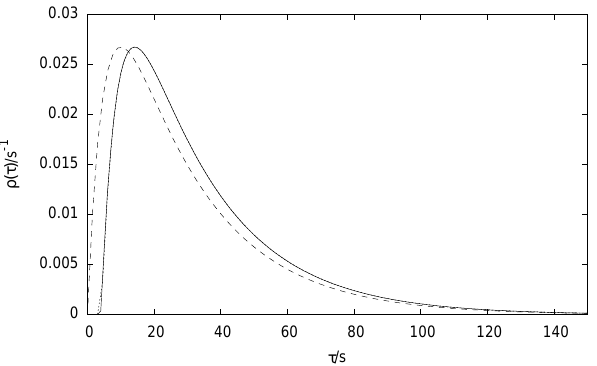
Fig. 4. Exact distribution of transcription times (solid curve replotted from figure 3), two-exponential approximate distribution (47) (dashed curve), and lag-corrected approximate distribution (48) (dotted, al- most coincident with the exact distribution). The two-exponential distribution uses the exact values of k 0 and k 4 , i.e. k 0 = 0 . 04 s − 1 and k 4 = 0 . 2 s − 1 . For the lag-corrected distribution, k 0 , k 4 and τ min are treated as fitting parameters, with least-squares estimates k 0 = 0 . 039 987 ± 0 . 000 021 s − 1 , k 4 = 0 . 2001 ± 0 . 0003 s − 1 , and τ min = 4 . 111 ± 0 . 004 s − 1